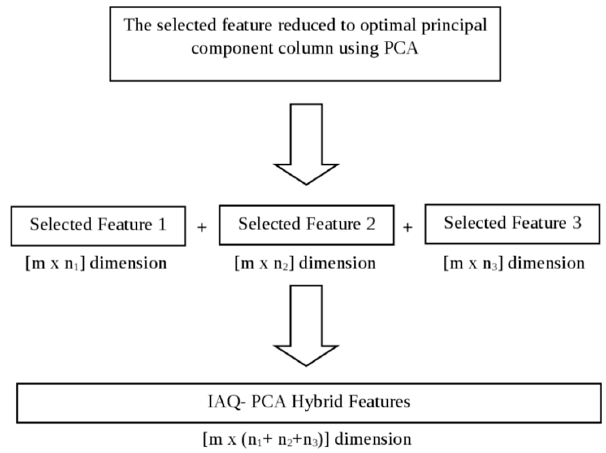
Figure 3. Feature Fusion Process for IAQ- PCA Hybrid Features.